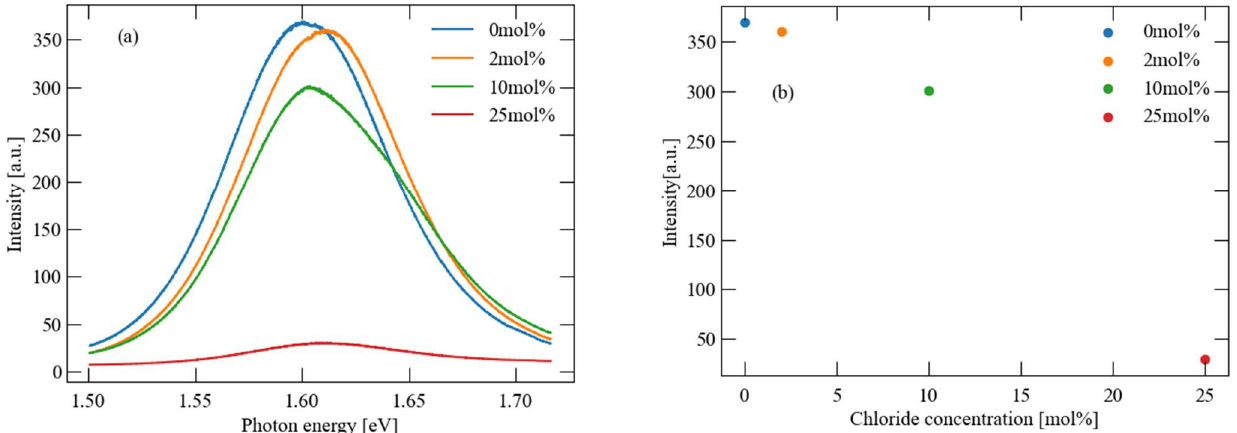
Figure 1. Photoluminescence (PL) ( a ) spectra and ( b ) intensity of CH 3 NH 3 Pb(Cl,I) 3 with different Cl concentrations on glass/ZrO 2 .